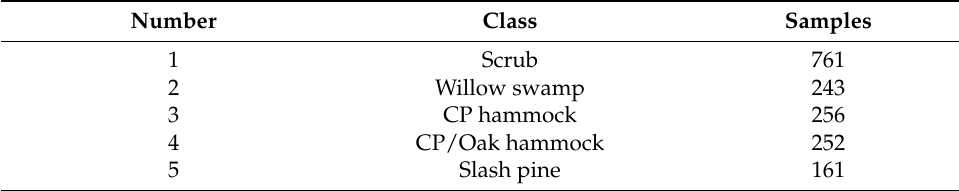
Table 3. Ground truth classes and their individual samples number for